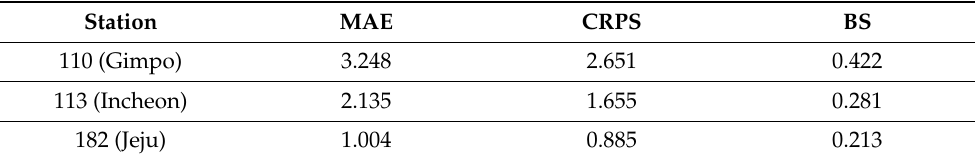
Table 4. Comparison of prediction skills of ensemble forecasts in terms of MAE, CRPS, and Brier score (BS) for all